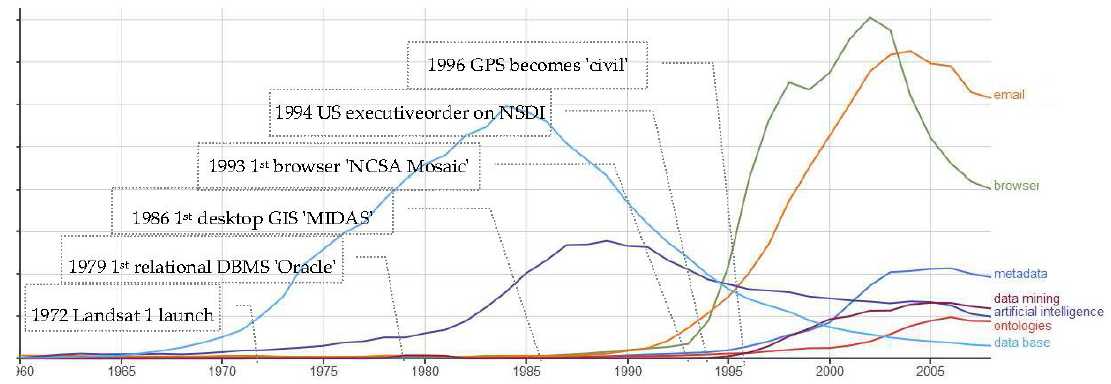
Figure 1. Data engineering: Major events and major buzzwords in the last 50 years.